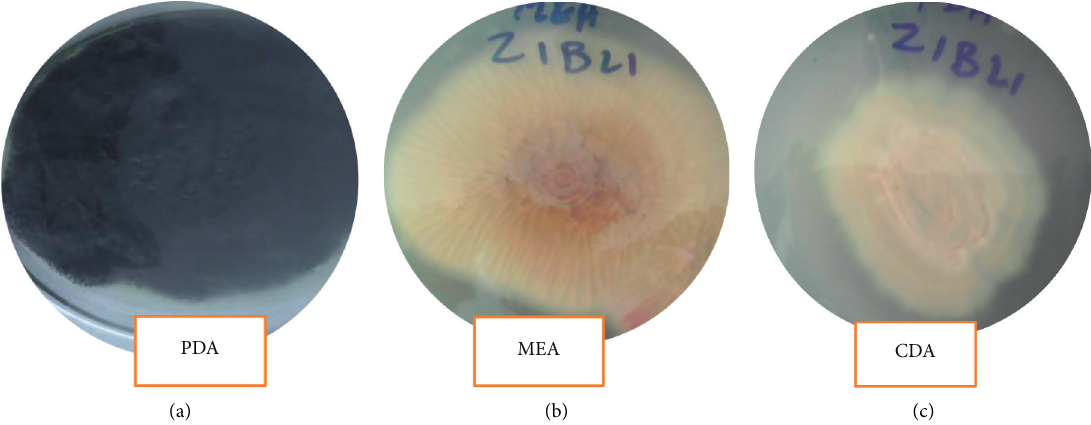
Figure 2: Macroscopic features of the isolate Z1BL1.